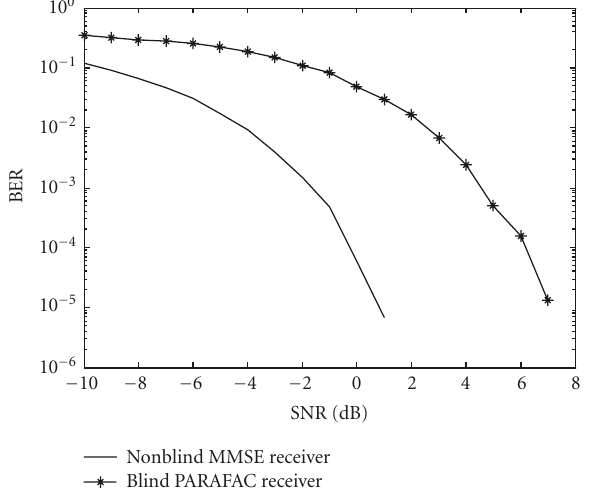
Figure 6: The algorithm performances comparison with N = 50.